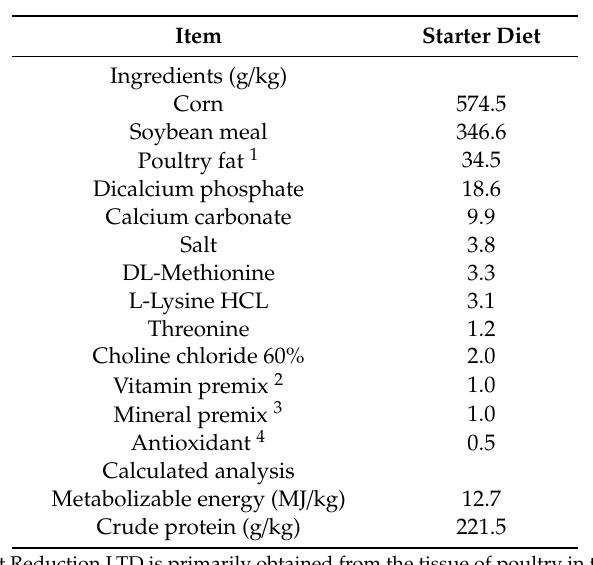
Table 1. Ingredient composition and nutrient content of a basal starter diet used in the experiments on as-is